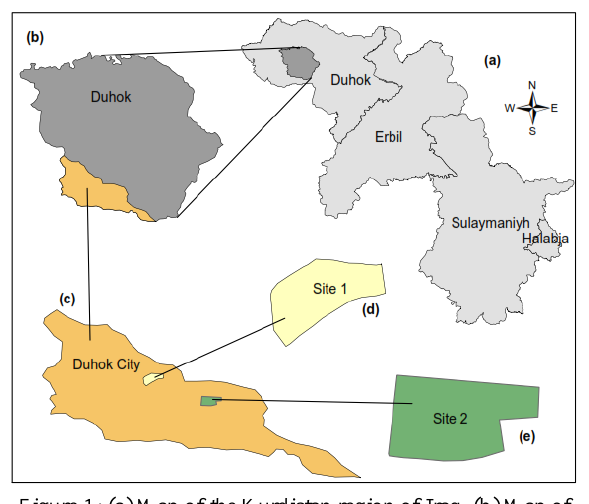
Figure 1: (a) Map of the Kurdistan region of Iraq, (b) Map of the Duhok district, (c) Map of the city of Duhok (d) Site 1 (e) Site 2.